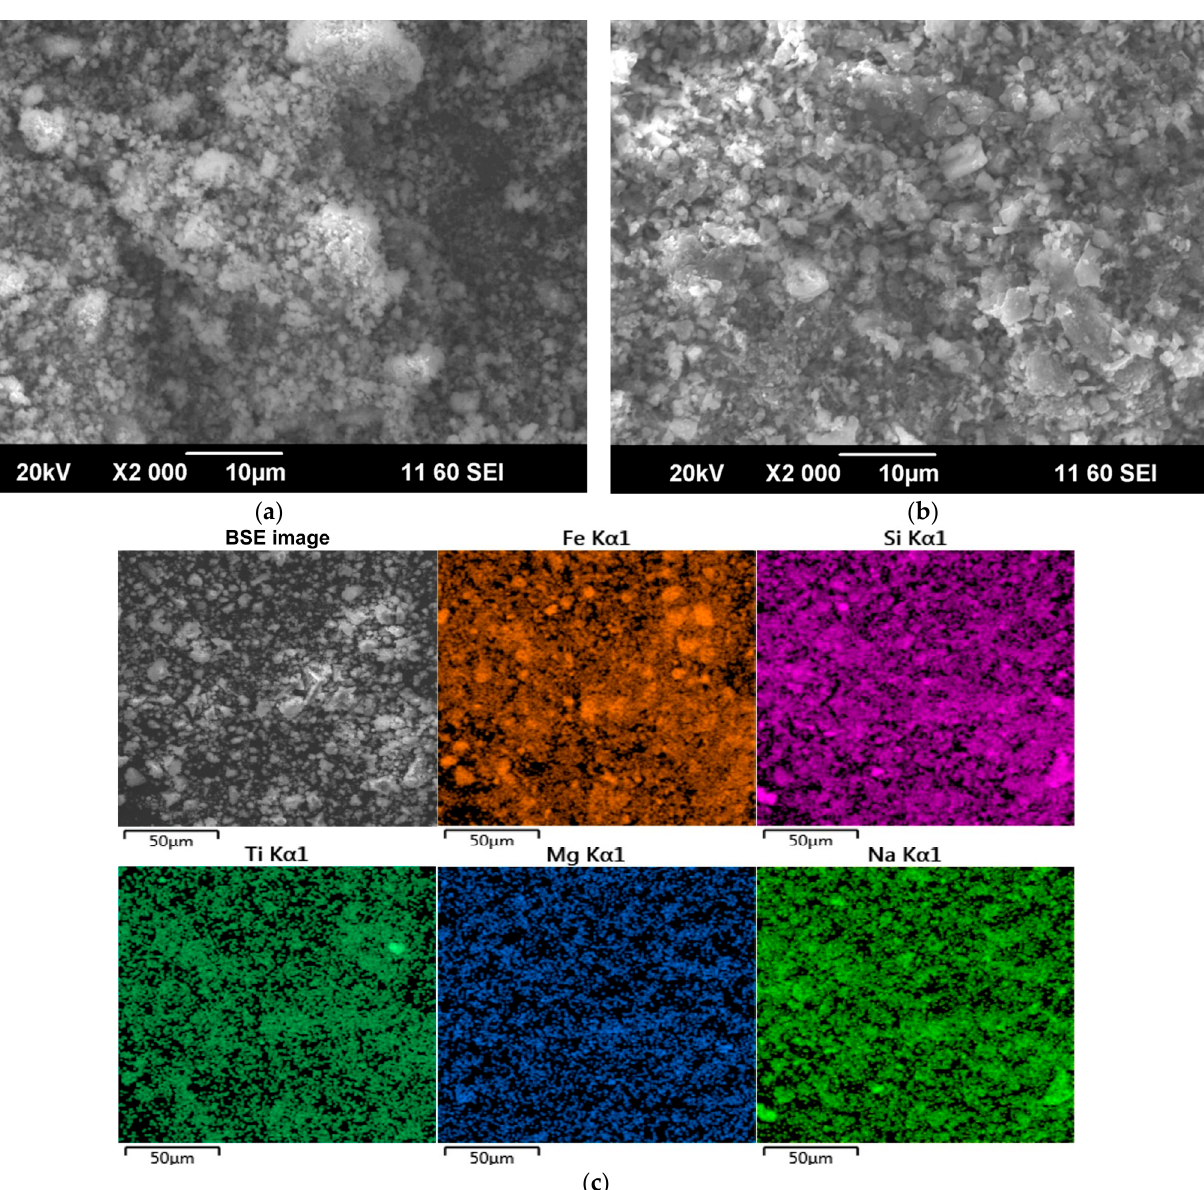
Figure 3. SEM images of: ( a ) the initial red mud obtained by alkali fusion-leaching of bauxite (RMF); ( b ) the Bayer red mud obtained from Middle Timan bauxite treatment on Urals Alumina Refinery; and ( c ) SEM image and EDS elemental mapping of RMF.